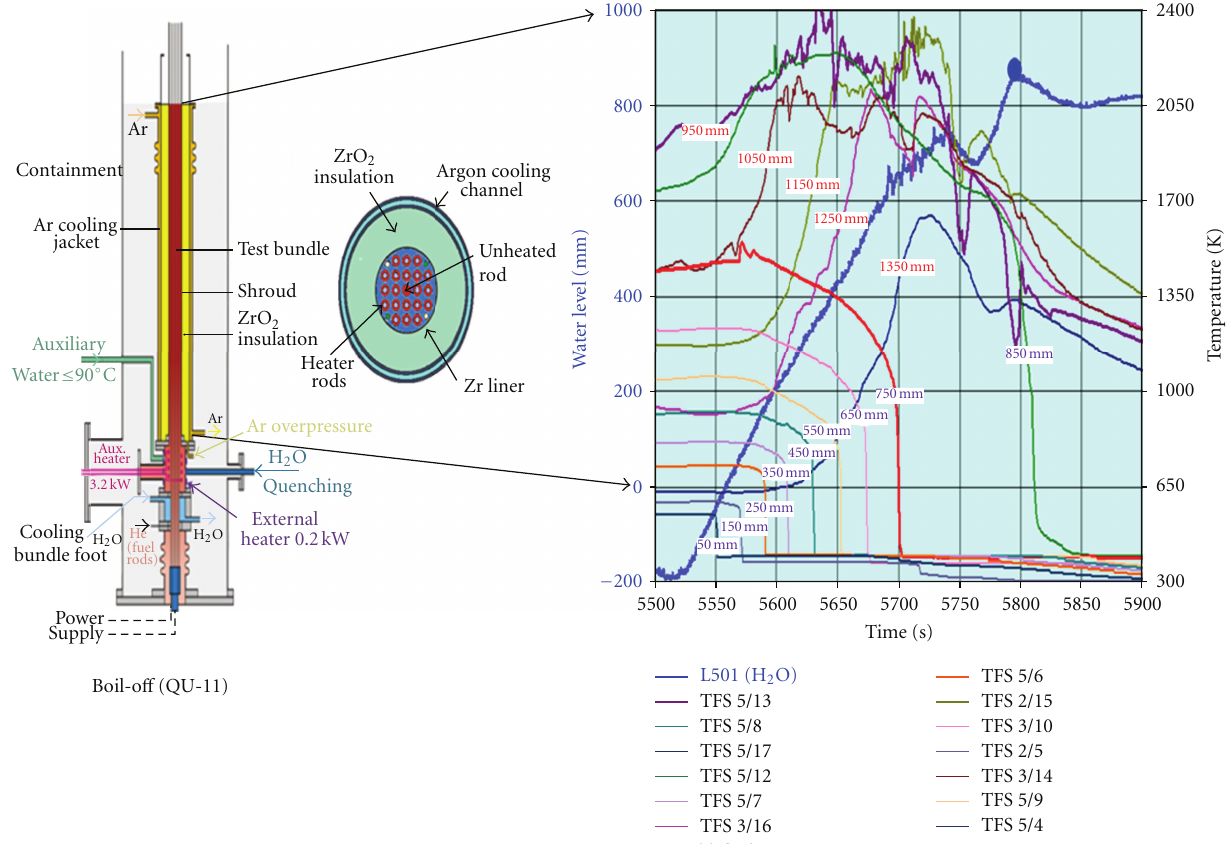
Figure 4: Measured temperatures and collapsed water level during the reflood phase in the Quench 11 experiment.